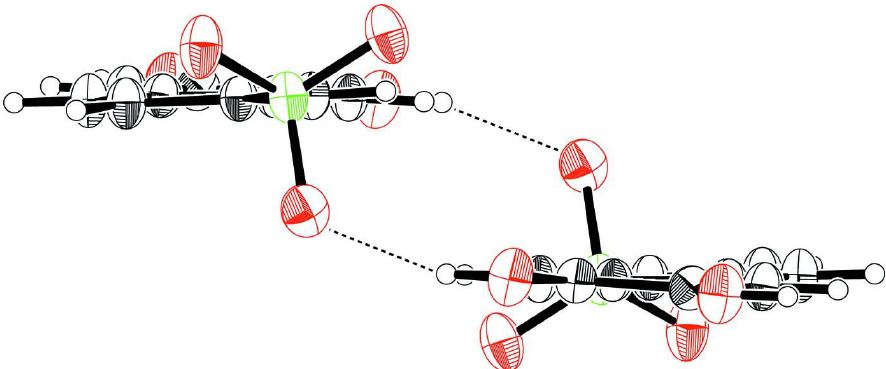
Figure 4 Hydrogen-bonded dimer unit B: (top view). The molecules are related by the symmetry operation (1–x, 1–y, –z).